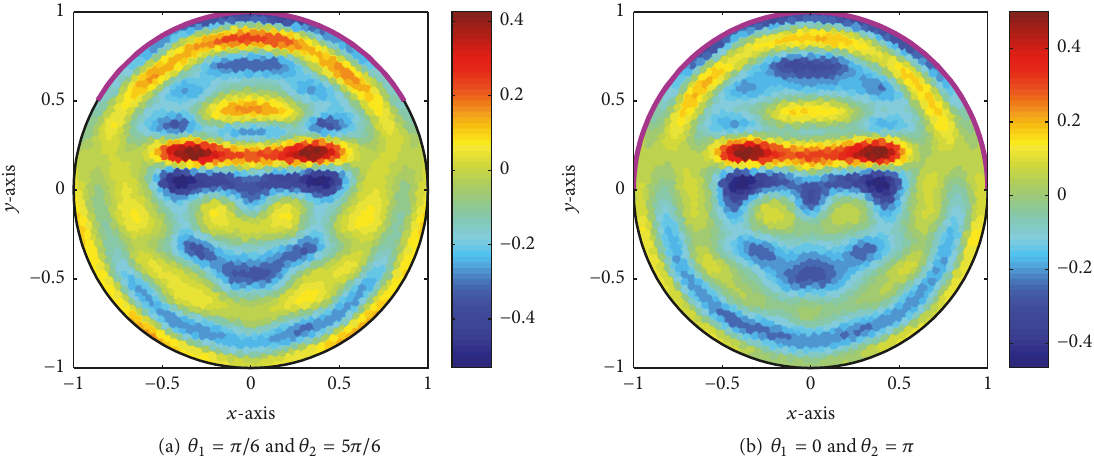
Figure 3: Same as Figure 1 except the range of the incident